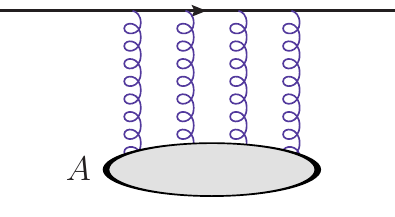
Figure 2: High energy quark interact- ing with classical gluon field.